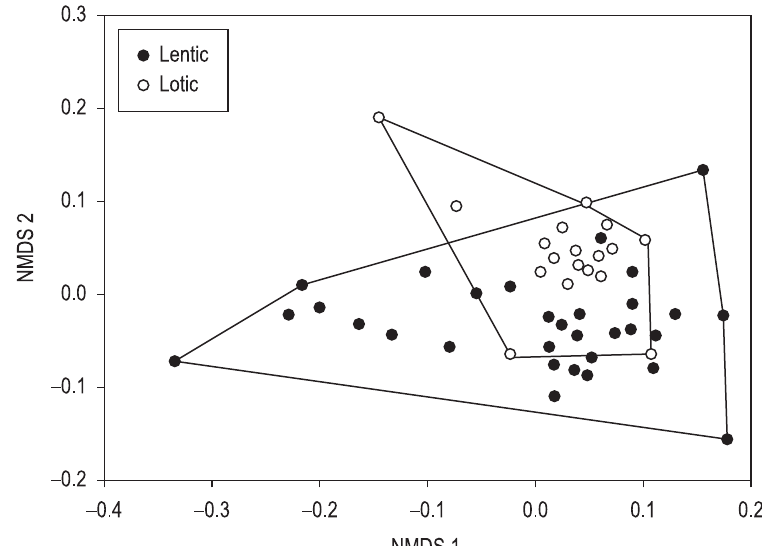
Figure 3. Non-metric multidimensional scaling analysis (NMDS) ordered according to Jaccard index for lentic and lotic water bodies. Stress =